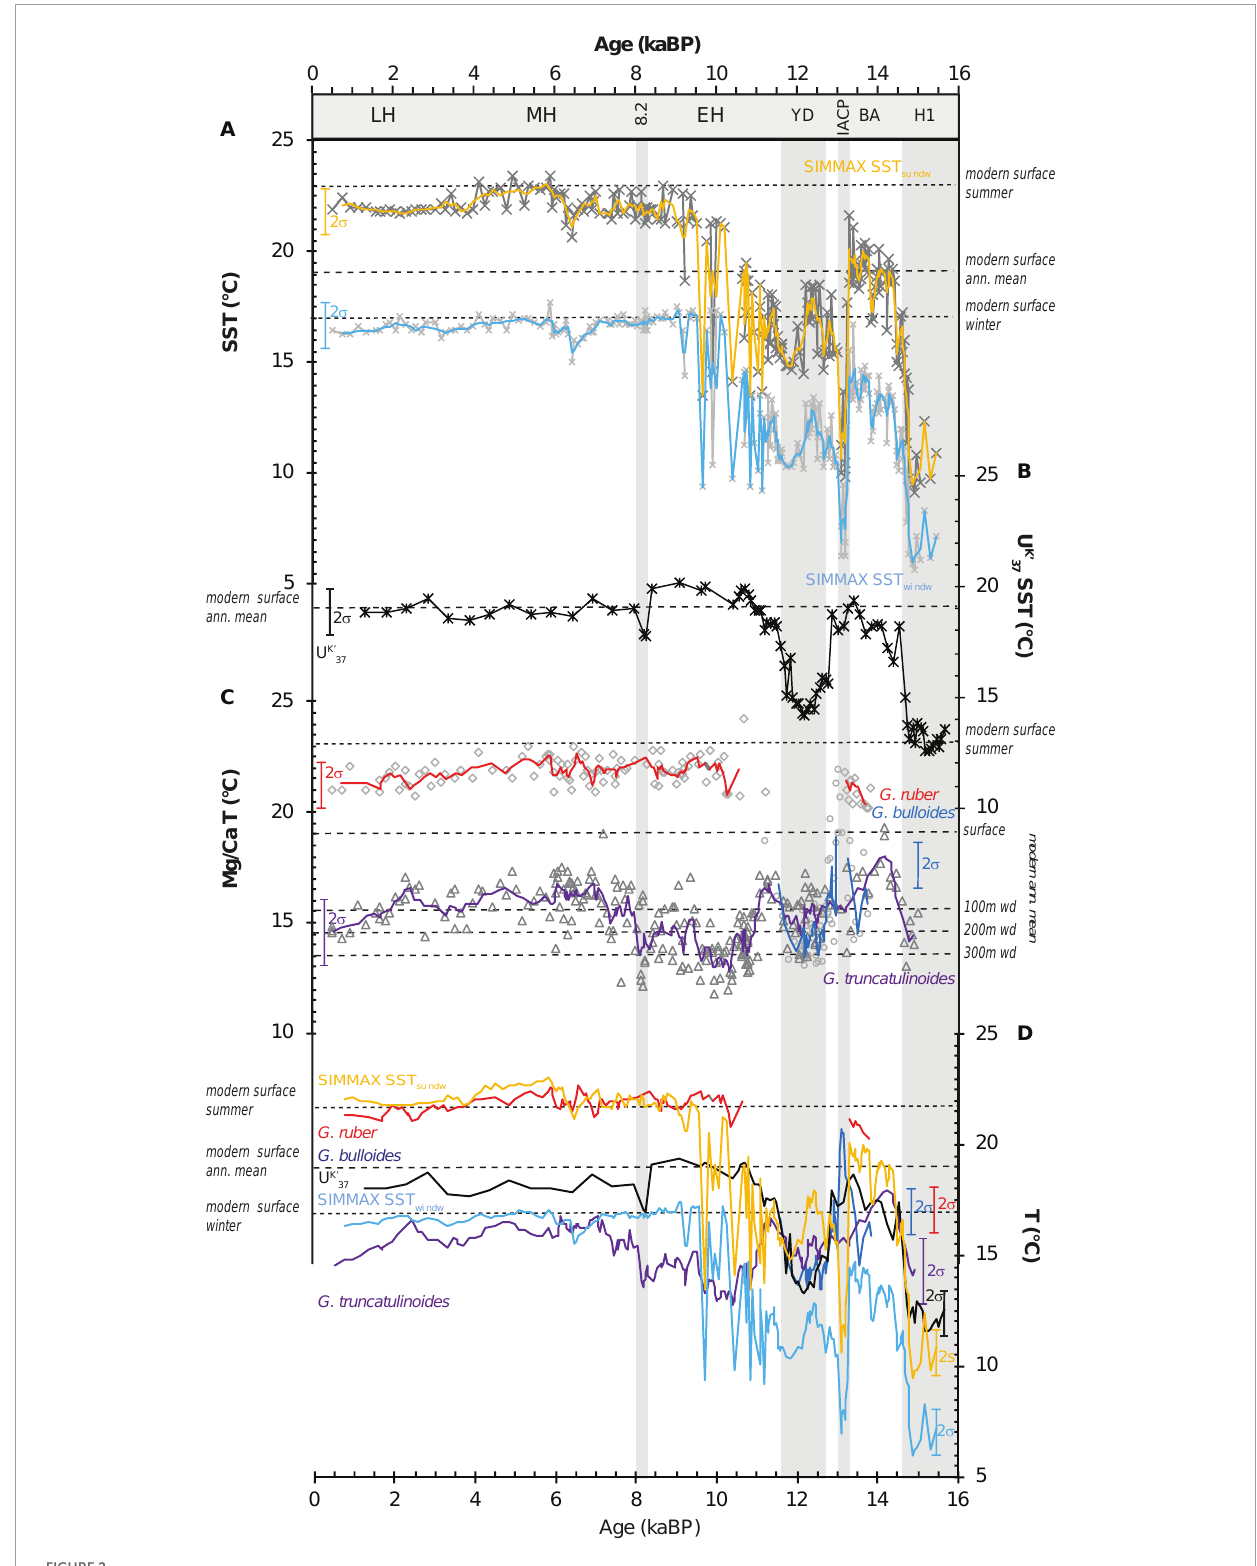
FIGURE2 Comparison of SST reconstructions from different proxies spanning the Last Glacial (H1) to Late Holocene (LH) time period. (A) Non-distance weighted SIMMAX summer (yellow) and winter (light blue) SST records. (B) Alkenone U K (cid:48) 37 SST estimates (black) (Schwab et al., 2012). (C) Surface water Mg/Ca SST obtained from G. ruber (red line) and G. bulloides (dark blue line) (Repschläger et al., 2015, 2017) and subsurface temperatures reconstructed from G. truncatulinoides Mg/Ca (violet line) (Repschläger et al., 2015, 2017). (D) Comparison of temperature reconstructions. Modern surface temperatures are shown for reference in horizontal bars. Lines in Mg/Ca SST records display three-point running mean values. BA Bølling-Allerød, IACP Intra Allerød Cold Period, YD Younger Dryas, EH Early Holocene, 8.2 8.2-ka-BP-Event, MH Mid Holocene, wd water